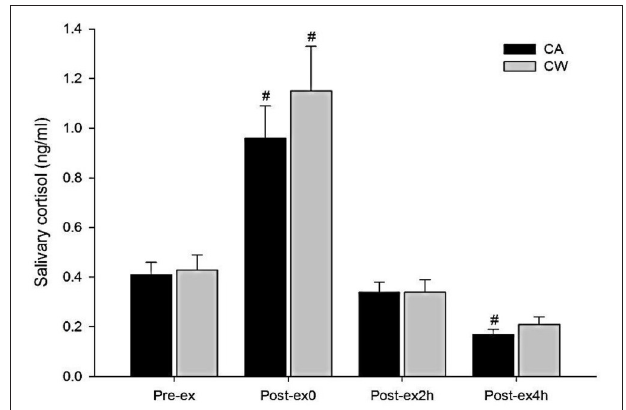
FIGURE 4 | Changes in salivary cortisol following main trials ( # vs. Pre-ex: P < 0.01, CA, CHO + Alpha-lactalbumin; CW, CHO + Whey PRO).